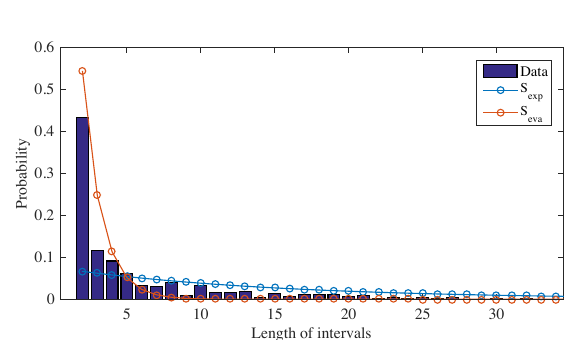
Figure 7 . The output probabilities of the exploration state, S exp , and the evaluation state, S eva , estimated using eye track- ing data of all participants. The bars represent the frequent distribution of segment